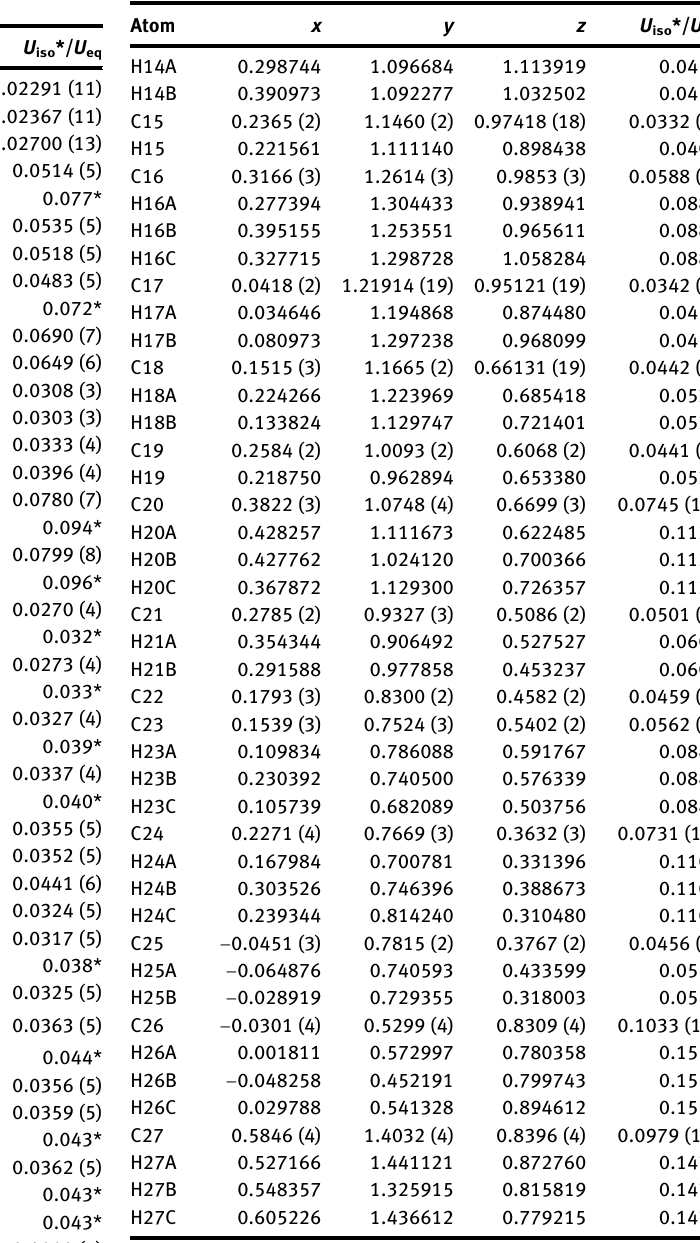
Table  : Fractional atomic coordinates and isotropic or equivalent isotropic displacement parameters (Å 